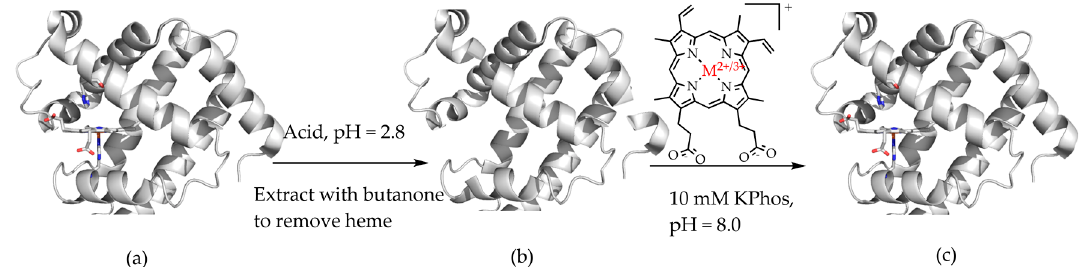
Figure 2. Teale’s method of cofactor replacement in hemoproteins: ( a ) acidification of protein to release the heme cofactor; ( b ) apoprotein followed by alkalination and reconstitution with new cofactor (M = Fe, Mn, Cr, Ru, Rh, or Co); ( c ) to regenerate new holoprotein [1].